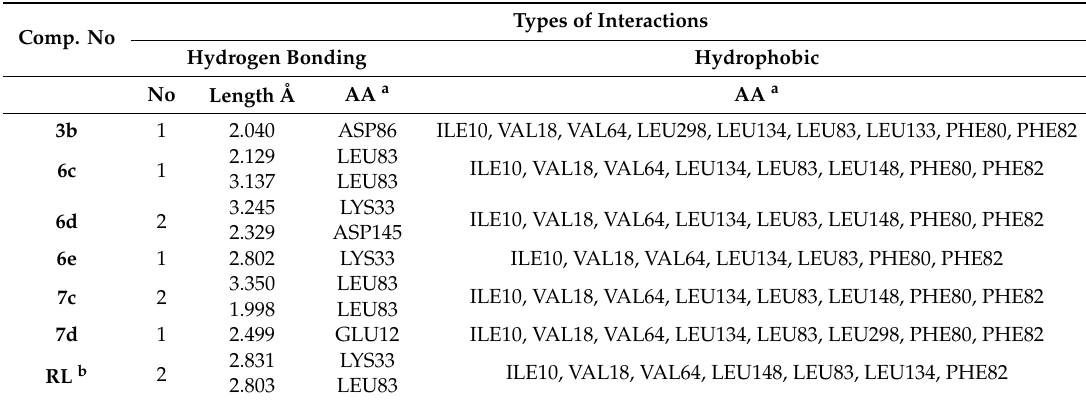
Table 3. Hydrogen bond and hydrophobic interaction for the most promising tested compounds into CDK2 binding pocket in comparison to the co-crystallized ligand. Comp.